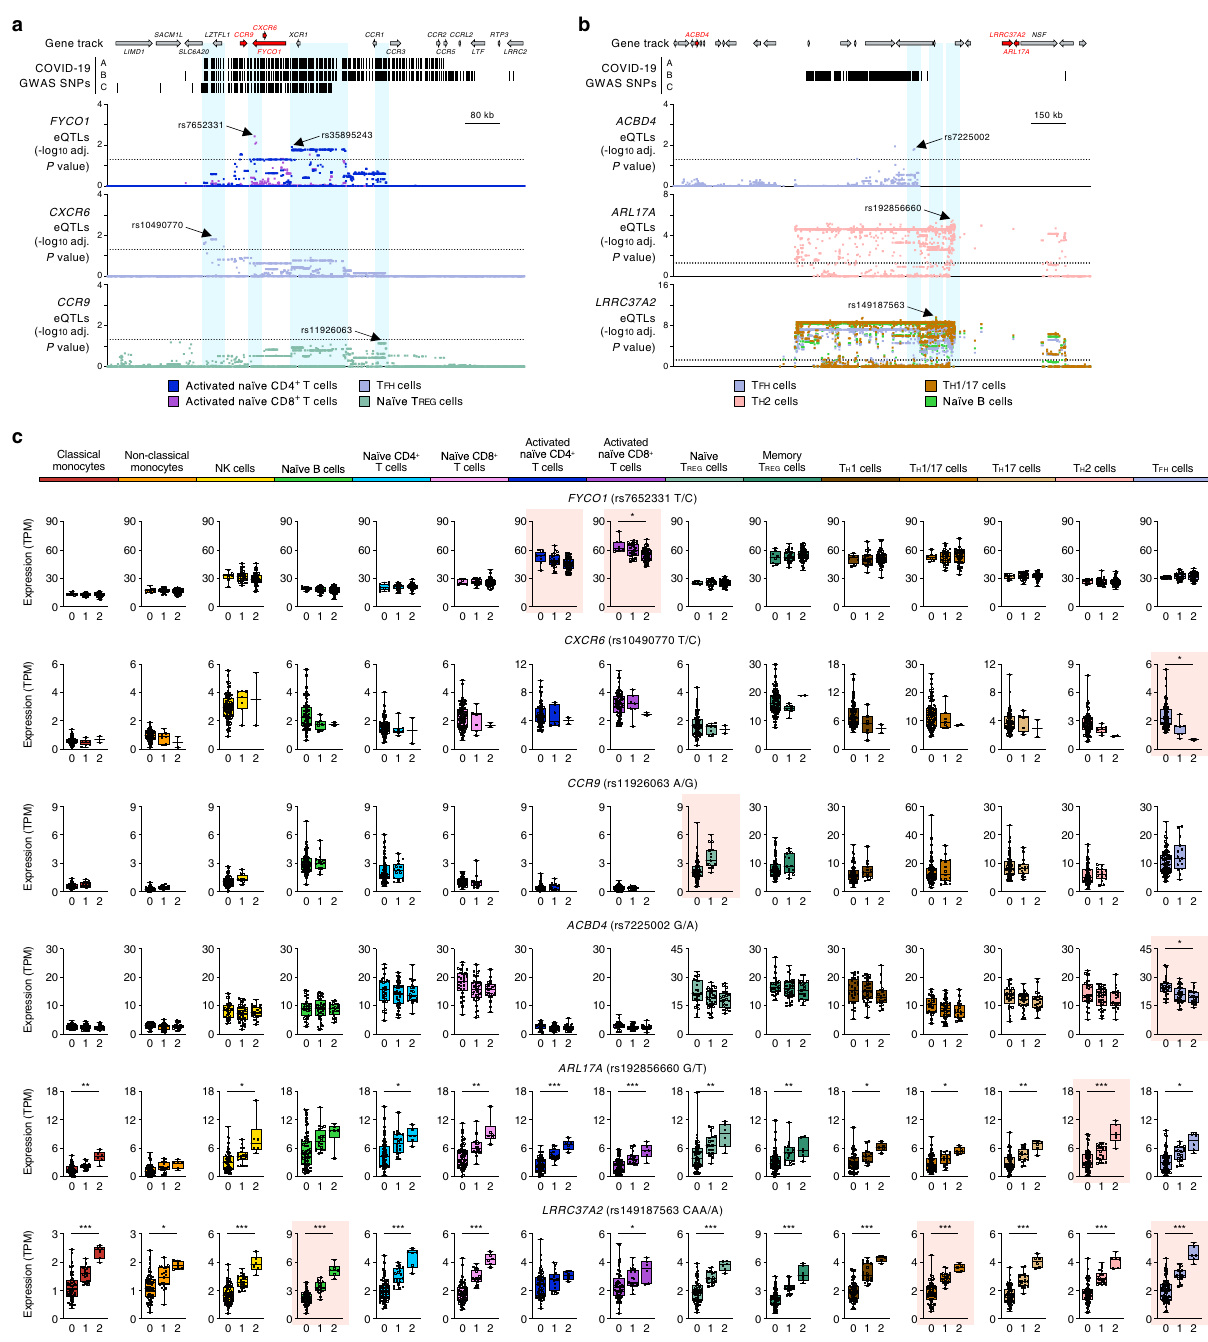
Fig. 4 COVID-19-risk-associated genes prioritized by colocalization analysis and TWAS. a WashU Epigenome Browser tracks for the gene locus on chromosome 3 harboring the genes FYCO1 , CXCR6 , and CCR9 , COVID-19-risk-associated GWAS variants (based on respective GWAS meta-analyses, see Supplementary Fig. 1a), adj. association P values for cis -eQTLs associated with expression of the indicated genes in various immune cell types and conditions. b WashU Epigenome Browser tracks for the gene locus on chromosome 17 harboring the genes ACBD4 , LRRC37A2 , and ARL17A , COVID-19-risk- associated GWAS variants (based on respective GWAS meta-analyses, see Supplementary Fig. 1a), adj. association P values for cis -eQTLs associated with expression of the indicated genes in various immune cell types and conditions. c Mean expression levels (TPM) of selected COVID-19-risk-associated GWAS eGenes (GWAS association P value <5 × 10 − 8 ), in the indicated cell types from subjects ( n = 91) categorized based on the genotype at the indicated GWAS cis -eQTL; each symbol represents an individual subject; adj. association P value * P < 0.05, ** P < 0.001, and *** P < 0.00001. The boxplots show the 25th percentile, median, and 75th percentile, with the whiskers indicating the minimum and maximum values. Signi fi cant associations with COVID-19 GWAS variants found by colocalization ( CXCR6 and FYCO1 ) or TWAS analysis ( CCR9 , CXCR6 , ACBD4 , ARL17A, and LRRC37A2 ) are highlighted for each speci fi c immune cell